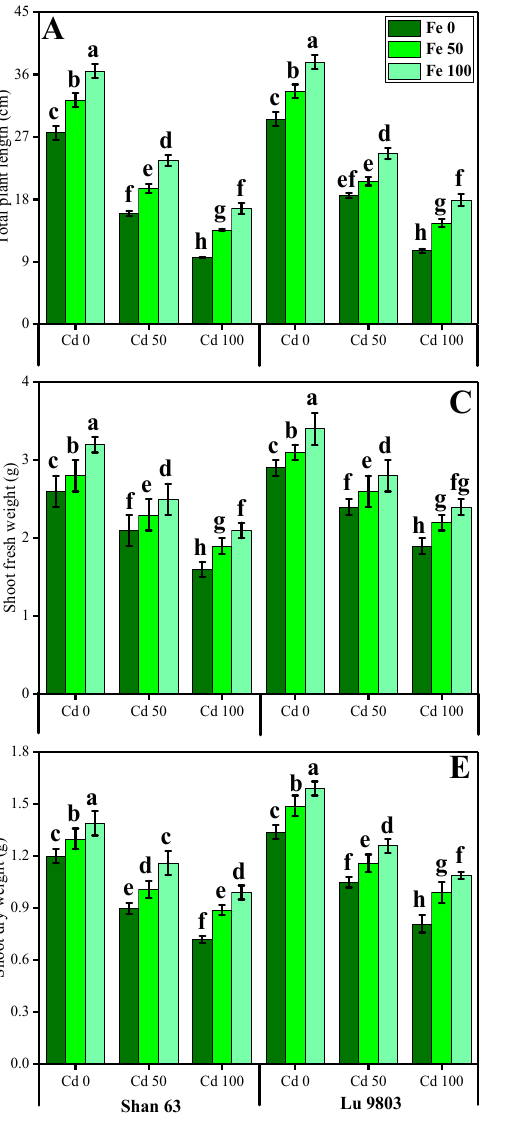
Figure 1. Effect of different concentrations of exogenous application of FeSO 4 (0, 50, and 100 µM) on morphological attributes, i.e., total plant length ( A ), root length ( B ), shoot fresh weight ( C ), root fresh weight ( D ), shoot dry weight ( E ) and root dry weight ( F ) of Oryza sativa (cultivars) grown under different levels of Cd stress (0, 50 and 100 µM). Bars sharing different letter(s) for each parameter are significantly different from each other according to Duncan’s multiple range test ( p < 0.05). All the data represented are the average of four replications ( n = 4). Error bars represent the standard deviation (SD) of four replicates.